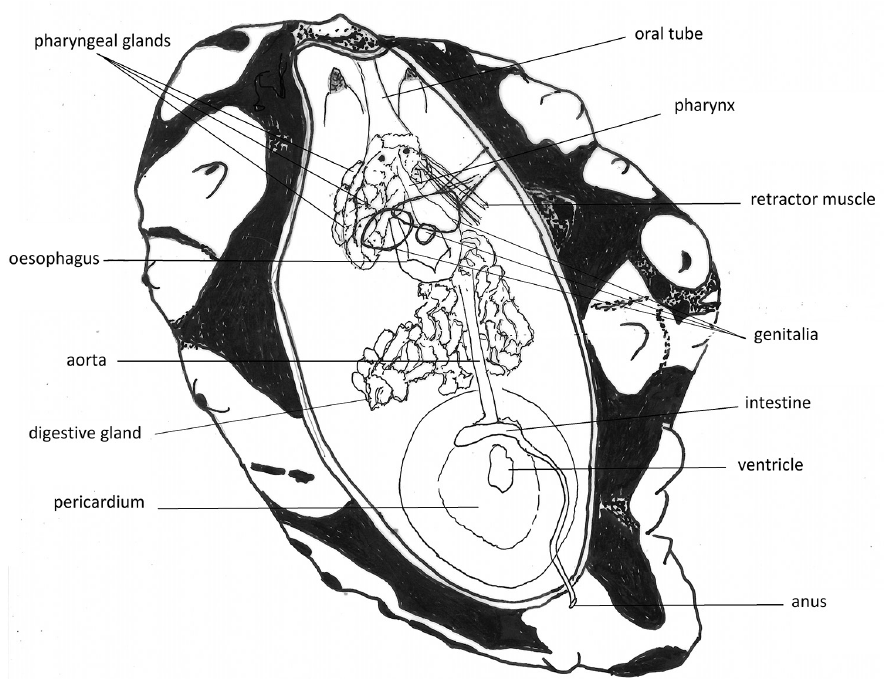
Figure 2. Phyllidiella amphitrite sp. nov., holotype SMF 360585, drawing of the digestive anatomy and the genitalia (the latter in heavier